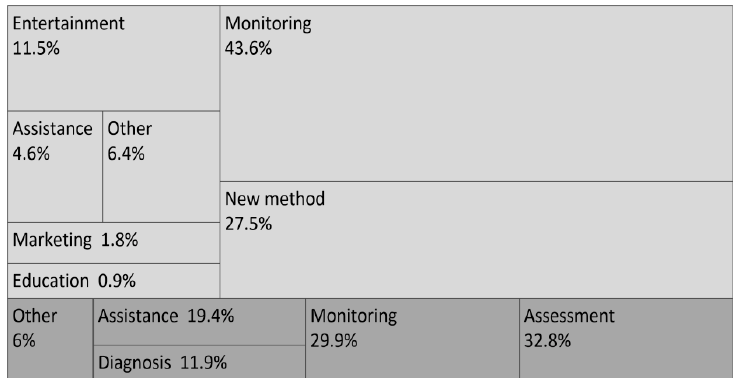
Figure 5. Treemap classification of articles by application domain and field ( non-medical medical).